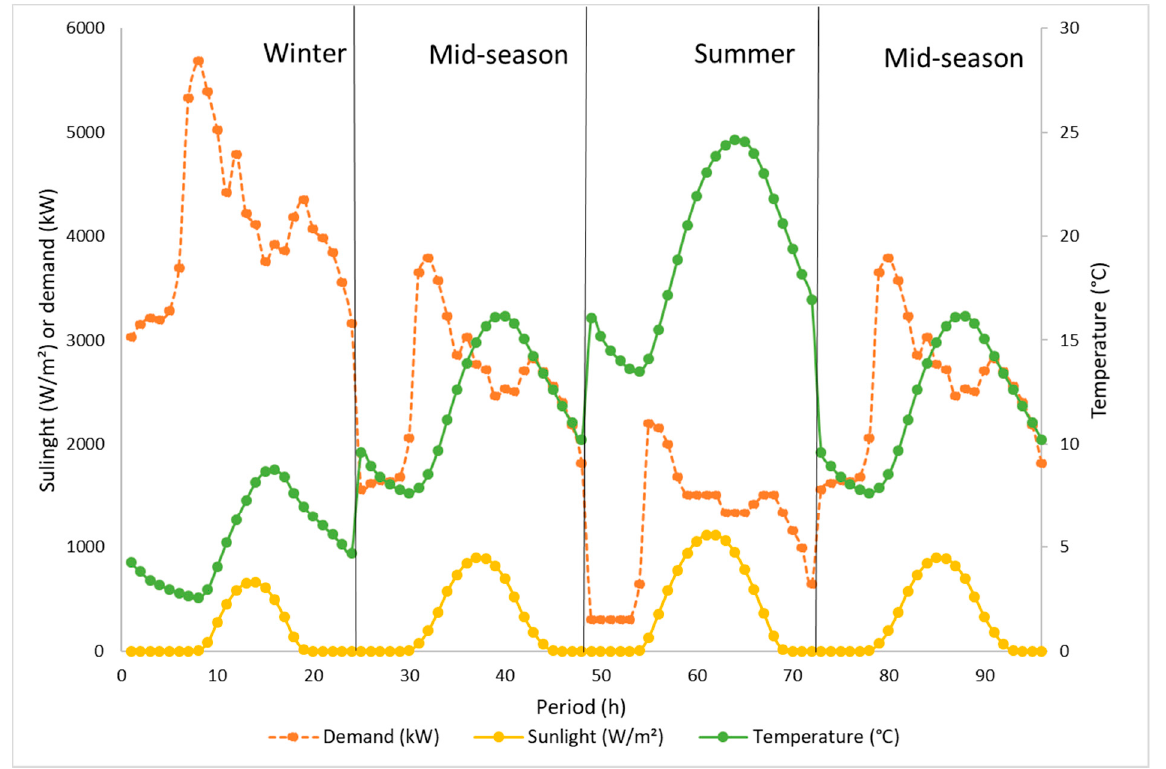
Figure 10. Profile of the three typical days: winter–mid-season–summer.